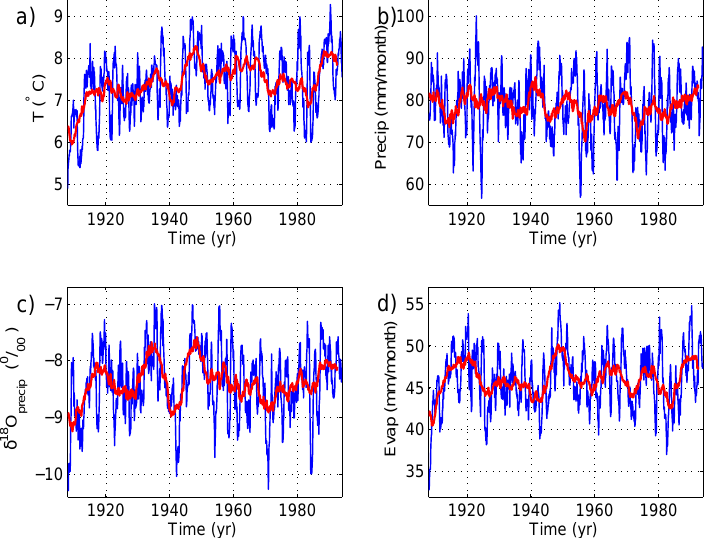
Fig. 1. Local input time series at the cave site: (a) surface temperature, (b) precipitation, (c) δ 18 O precip , (d) evaporation values at Bunker Cave. Blue lines indicate the 12-month and red lines the 60-month running mean values,